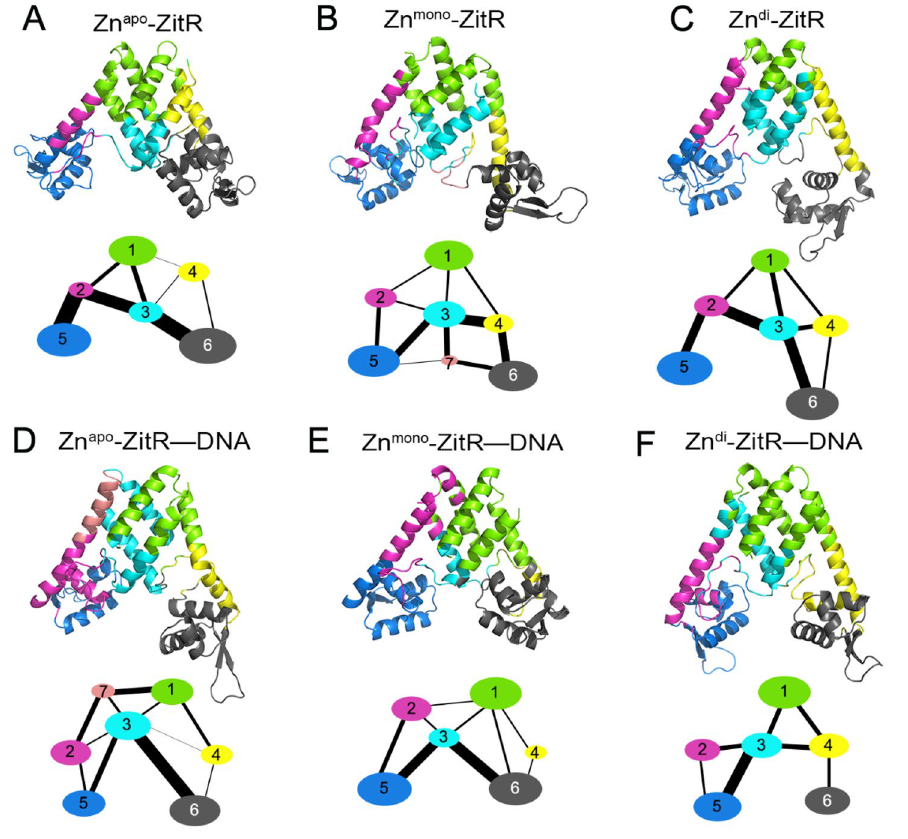
Figure 6. Colored community networks of Zn apo –ZitR ( A ), Zn mono –ZitR ( B ), Zn di –ZitR ( C ), Zn apo –ZitR–DNA ( D ), Zn mono –ZitR–DNA ( E ), and Zn di –ZitR–DNA ( F ). Color scheme: community 1 (C1, green), community 2 (C2, magenta), community 3 (C3, cyan), community 4 (C4, yellow), community 5 (C5, blue), community 6 (C6, black) and community 7 (C7, salmon). Each oval represents an individual community. The area of it is in direct proportion to the number of its residues. The widths of lines connecting ovals are proportional to the